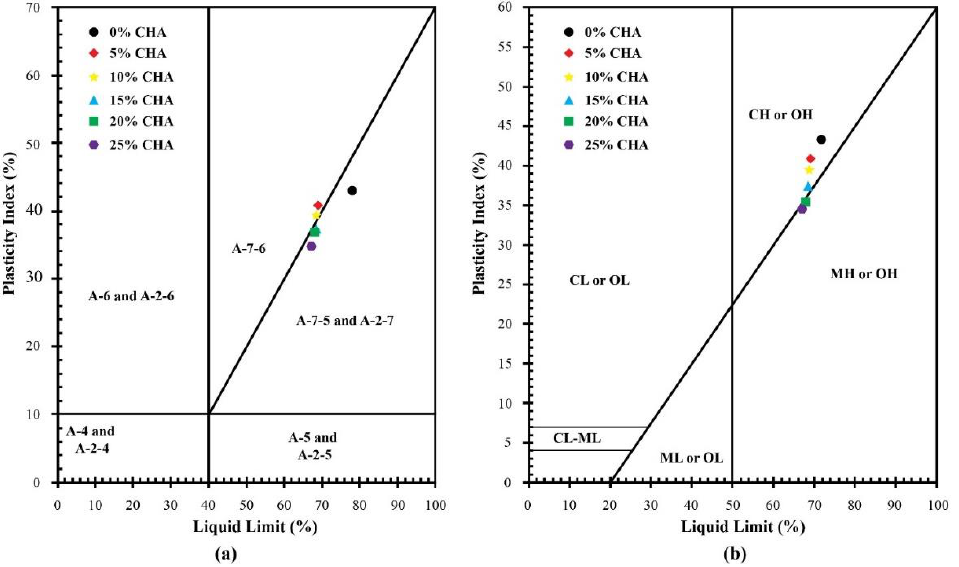
Figure 5. PI-LL for untreated and treated samples using the plasticity charts of AASHTO ( a ) and USCS ( b ).